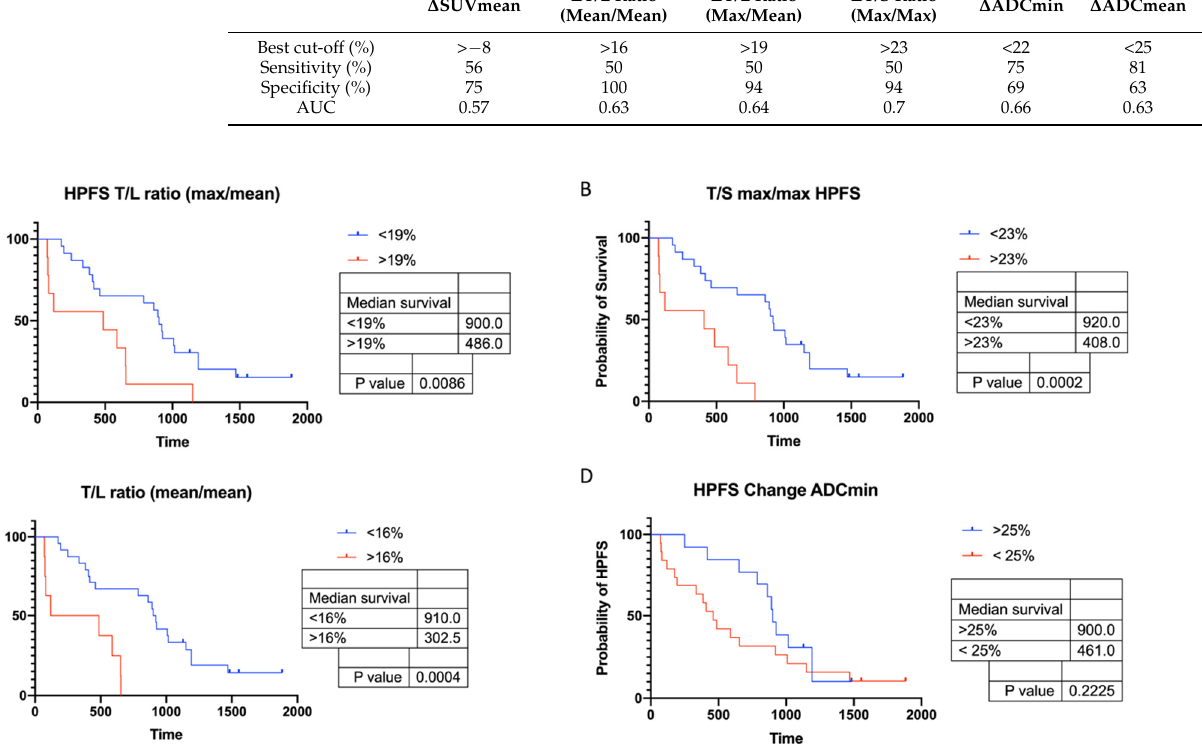
Figure 7. Kaplan–Meier curves for HPFS stratified by percentage changes of SUV and ADC between baseline and first follow-up after TARE. A lower percentage increase of SUV T/L ratio (max/mean), SUV T/L ratio (mean/mean), and SUV T/S ratio (max/max) showed significant effects on HPFS. ( A–C ) Patients with ∆ T/S (max/max) > 23% had significantly shorter HPFS than those with ∆ T/S (max/max) < 23% ( B ). Patients with an increase of ADCmin > 25% tended to have longer HPFS, although not significantly ( D ). p values were calculated with log-rank test. Table 7. ROC analysis of SUV and ADC for predicting HPFS < 24 months.